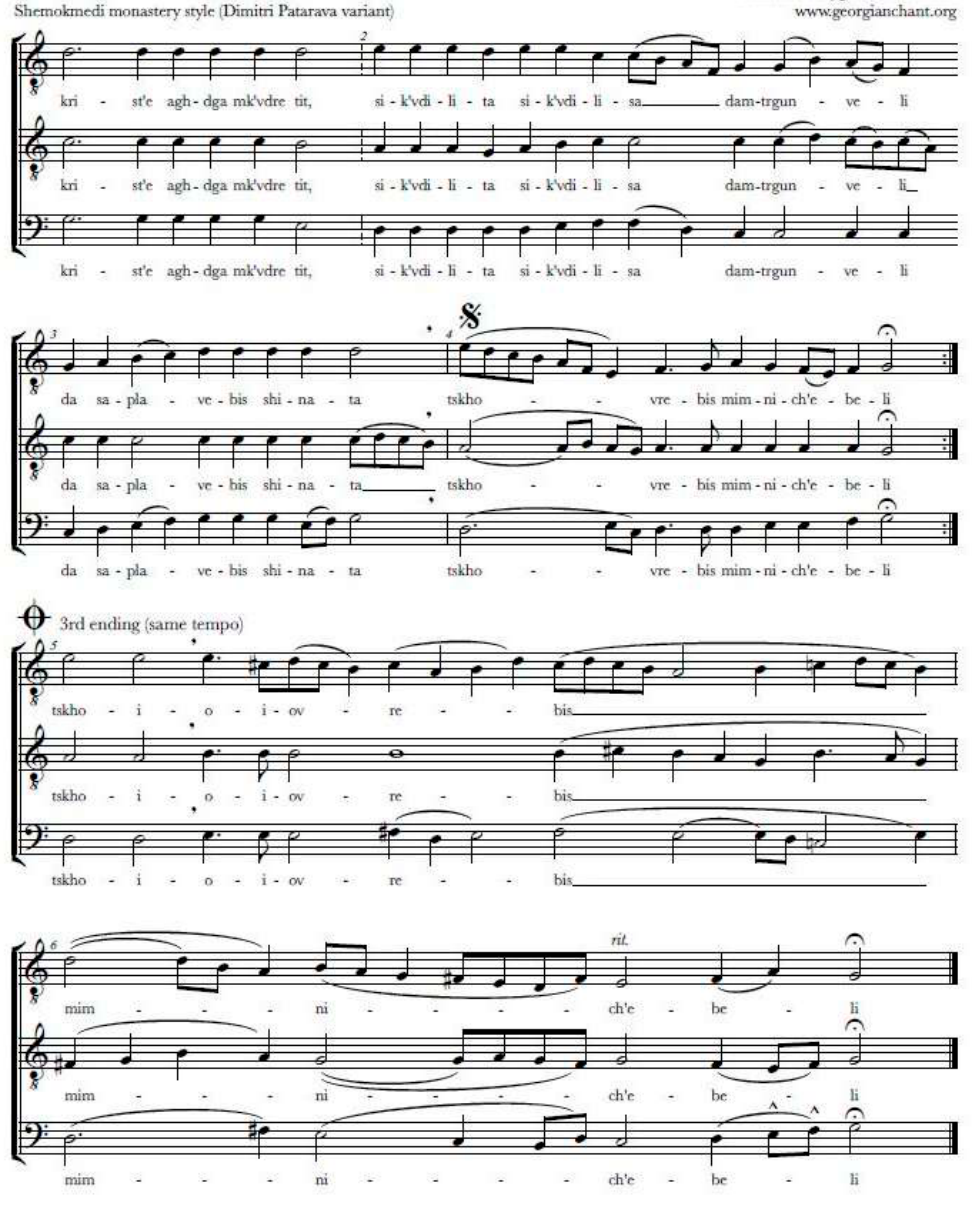
Figure 2. Paschal Troparion; Svetitskhoveli School.